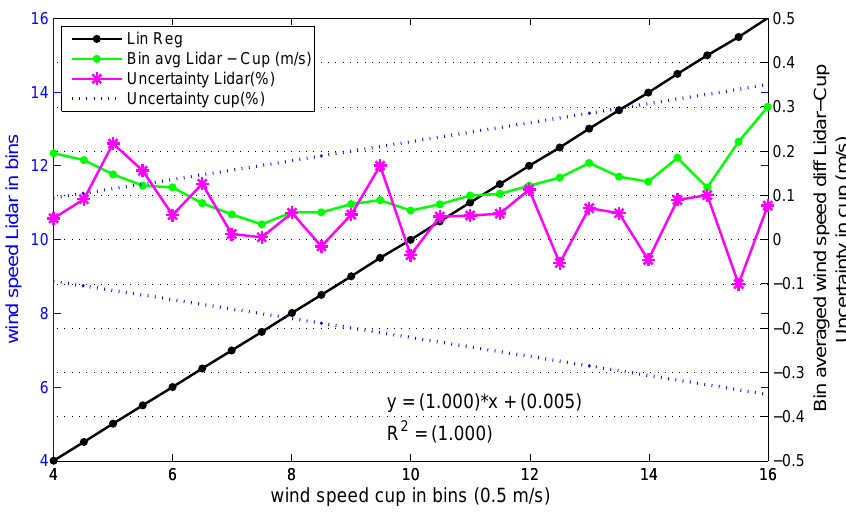
Figure 3. Verification test for wind speed deviation between Lidar and cup anemometer at 80m height. Verification test comprising of the binwise deviations of the wind speed difference between cup and Lidar, uncertainty of cup and statistical uncertainty of the